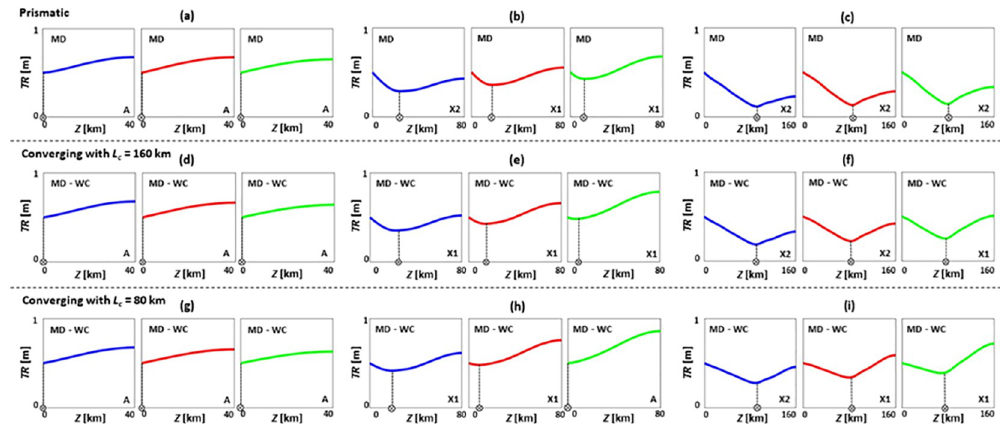
Fig 3. Tidal range TR patterns of prismatic (a-c), converging with L c = 160 km (d-f), and converging with L c = 80 km (g-i) estuaries under SLR, where TR = 0.5 m, Q / TP = 0% (no river discharge), n = 0.03 s/m 1/3 , h = 5 m, and θ = 0˚. (a), (d), and (g) 0 are short estuaries ( Z = 40 km); (b), (e), and (h) are moderate estuaries ( Z = 80 km); and (c), (f), and (i) are long estuaries ( Z = 160 km). Blue, red, and green colours show base case (no SLR), 1 m of SLR, and 2 m of SLR scenarios, respectively. Patterns A, X1, and X2 are the general TR patterns introduced in Fig 2. MD and WC refer to moderately dissipative and weakly converging estuaries,